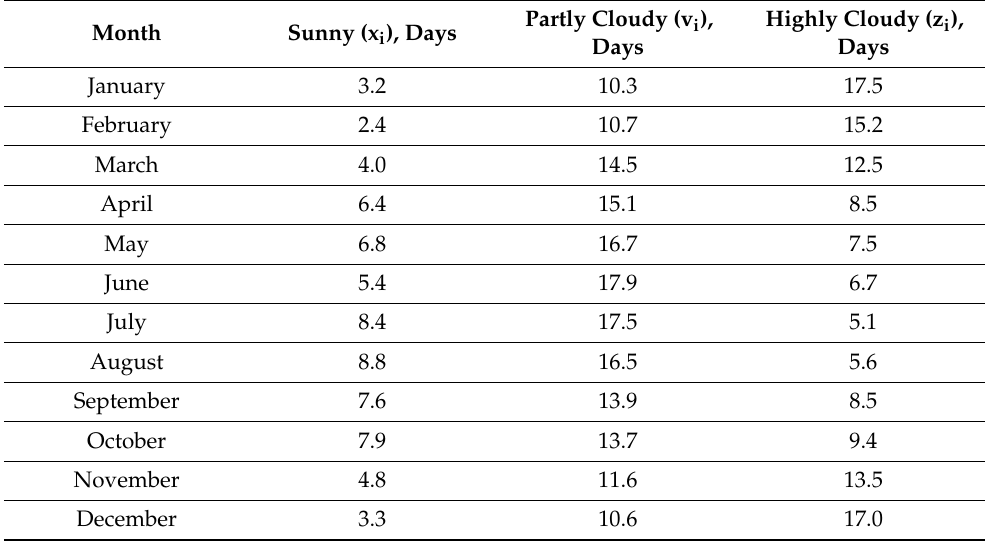
Table 7. Historical data of average number of days by cloud cover level and months, days